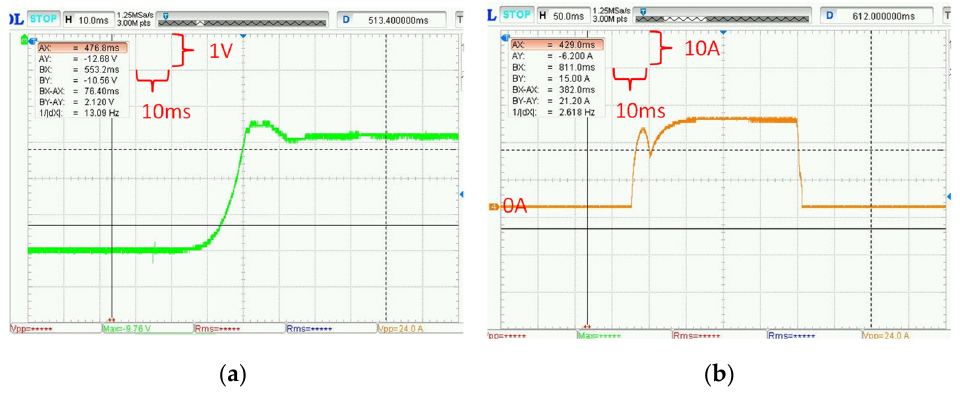
Figure 15. The opening dynamic characteristics of the prototype. ( a ) The mover position in opening process. ( b ) The current in opening coil.